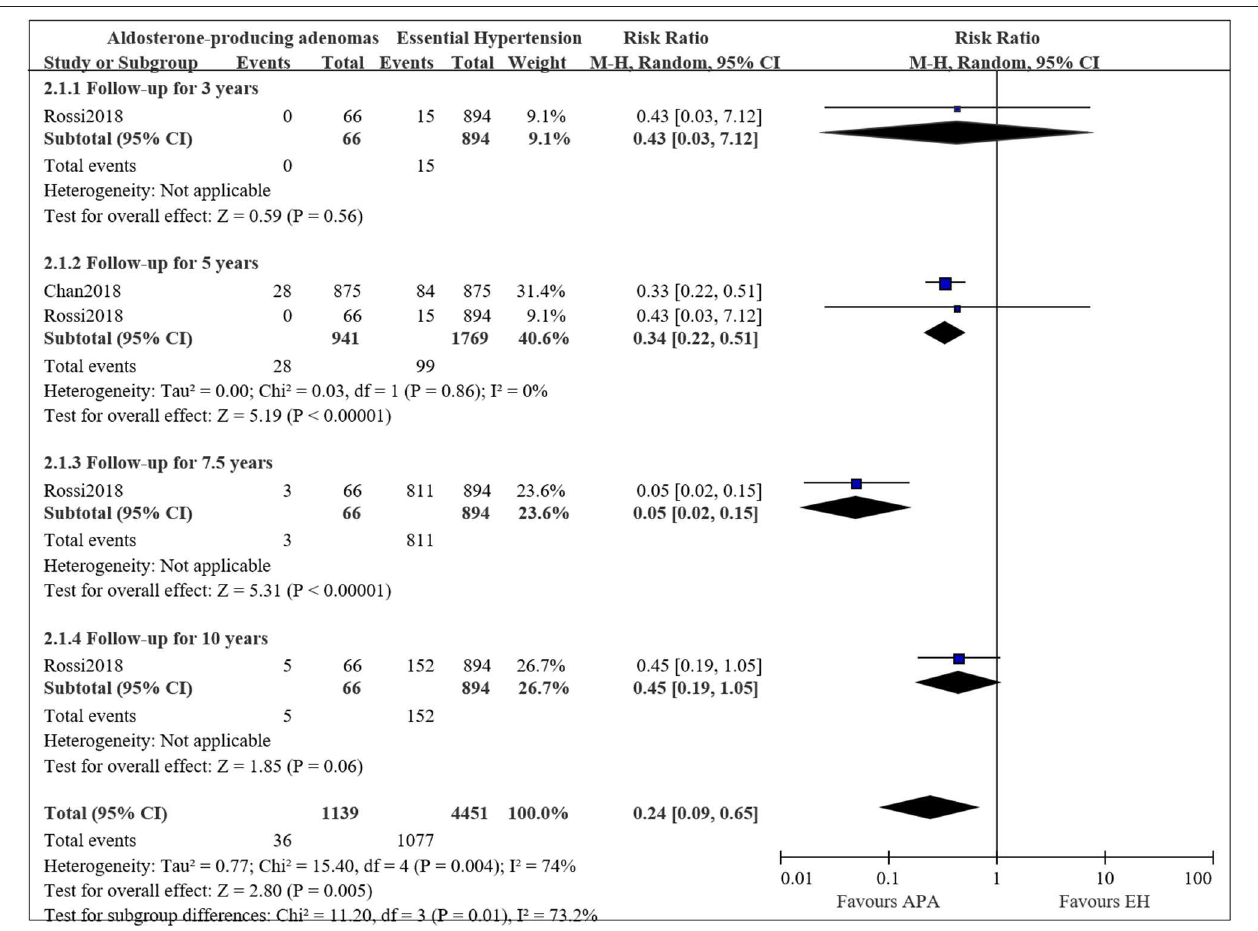
FIGURE 3 | Comparison of patient with APA and EH of the risk of mortality at different follow-up